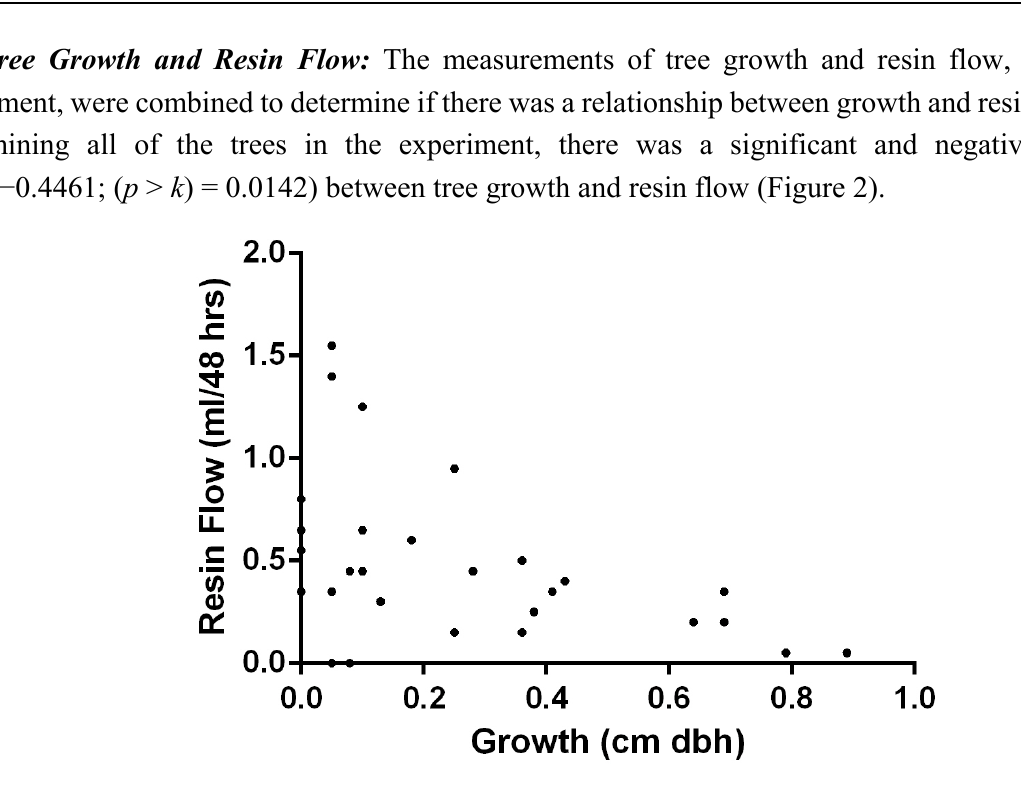
Figure 2. Association ( k = − 0.4461; ( p > k ) = 0.0142) of resin flow (mL/48 h) and